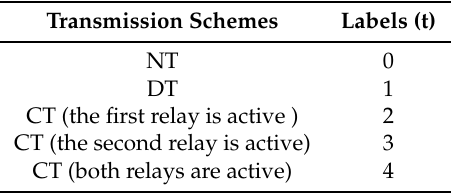
Table 1. Example of labeling for the system with two relays ( N r =